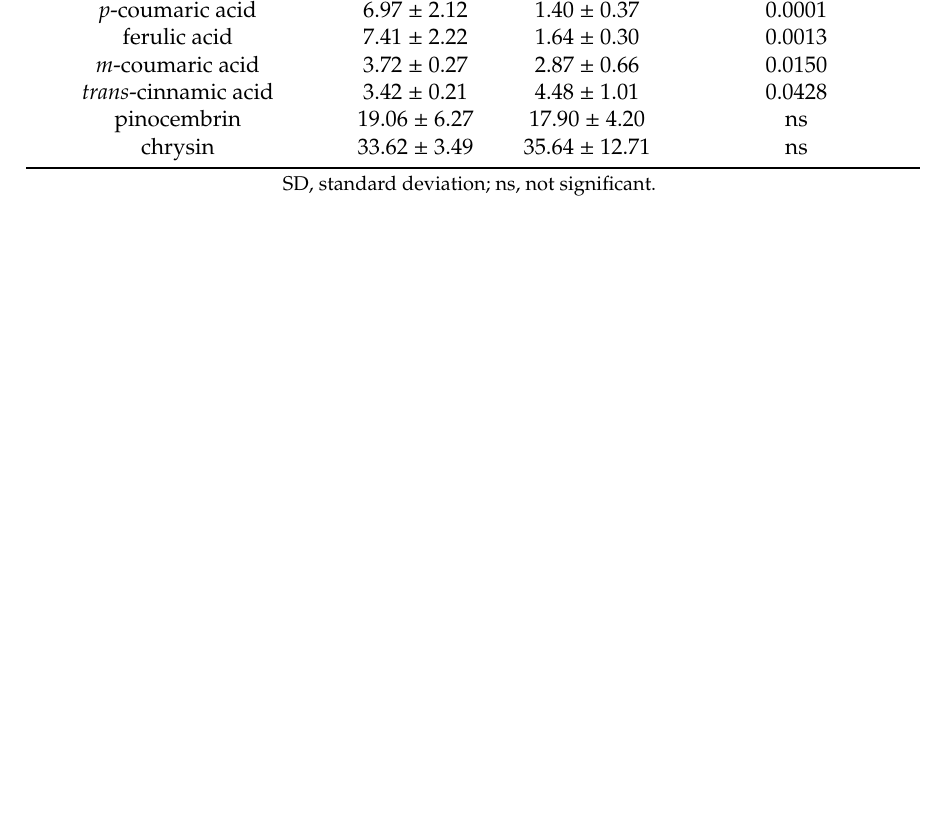
SD, standard deviation; ns, not significant; DS, degrees of freedom.